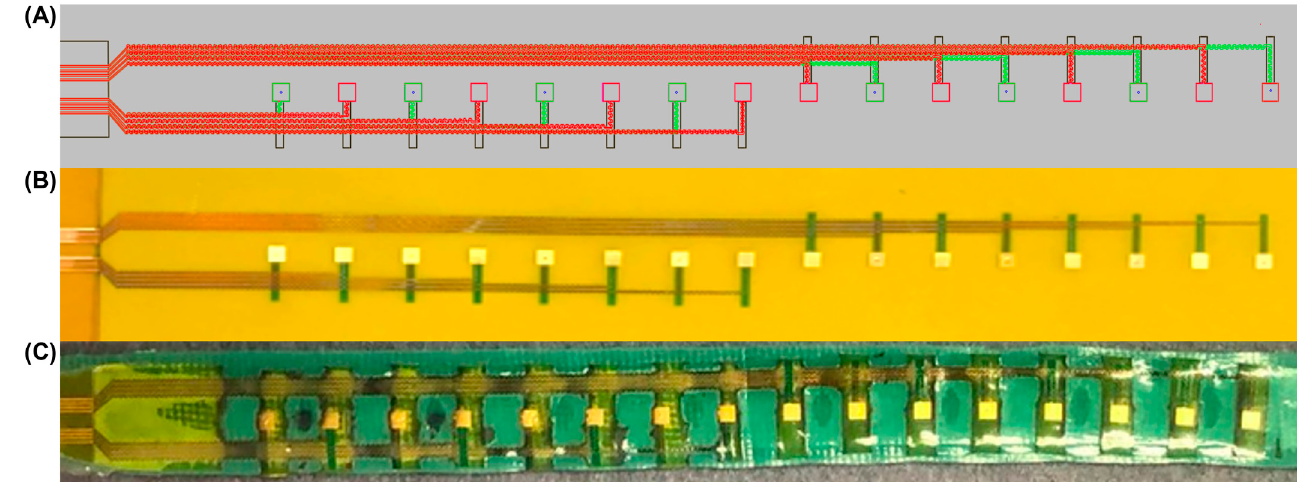
Figure 2. ( A ) The 2D CAD design of dual-layer fl ex-PCB, ( B ) real image of unprocessed dual-layer fl ex-PCB coated with an electroless nickel immersion gold (ENIG) fi nish, and ( C ) processed dual- flex-PCB coated with an electroless nickel immersion gold (ENIG) finish, and ( C ) processed dual-layer layer fl ex-PCB ENIG actuator. flex-PCB ENIG actuator.